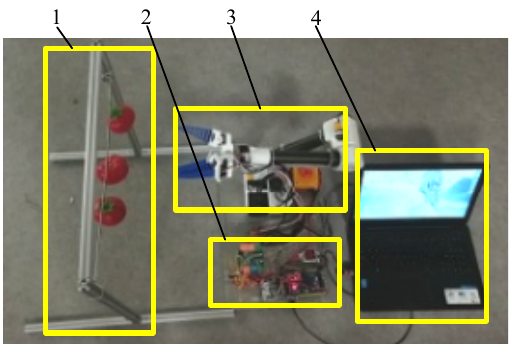
Figure 20. Experimental environment II. 1. Tomato hanger; 2. Control platform; 3. Manipulator; 4. Visual processing platform.